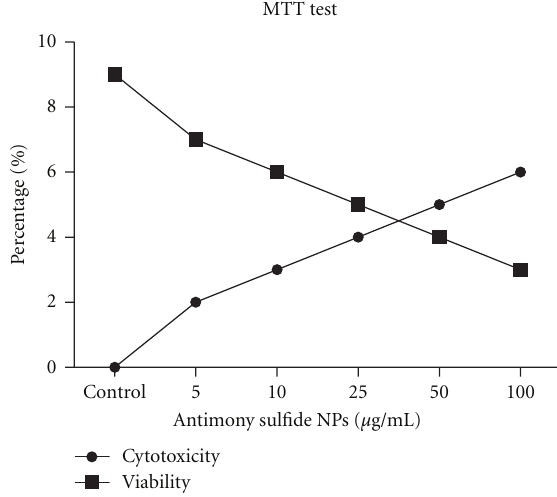
Figure 2: Percentage of viability of promastigotes of Leishmania infantum and cytotoxicity of 5 dilutions of antimony sulfide NPs at 72 hours by MTT method.